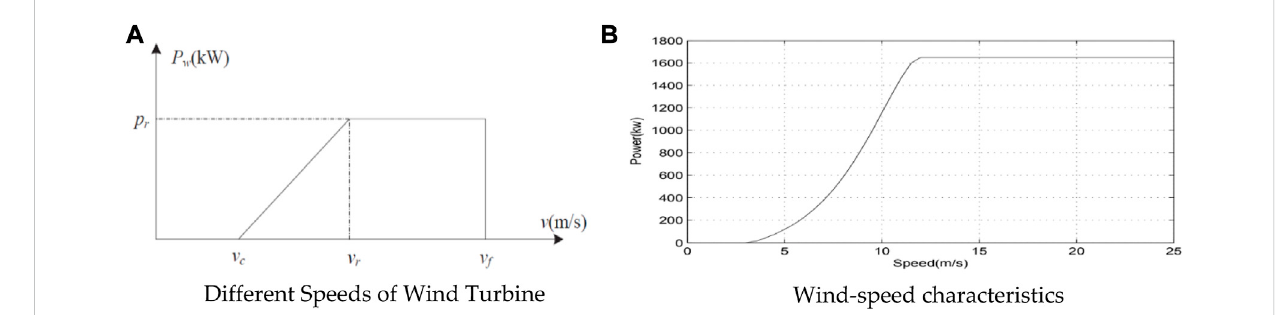
FIGURE 3 Different parameters of wind turbines for the analysis of their power and speed generation. (A) The curve of different speeds of wind turbines (Yona et al., 2007). (B) Waveform showing the wind speed characteristics (Habib et al.,